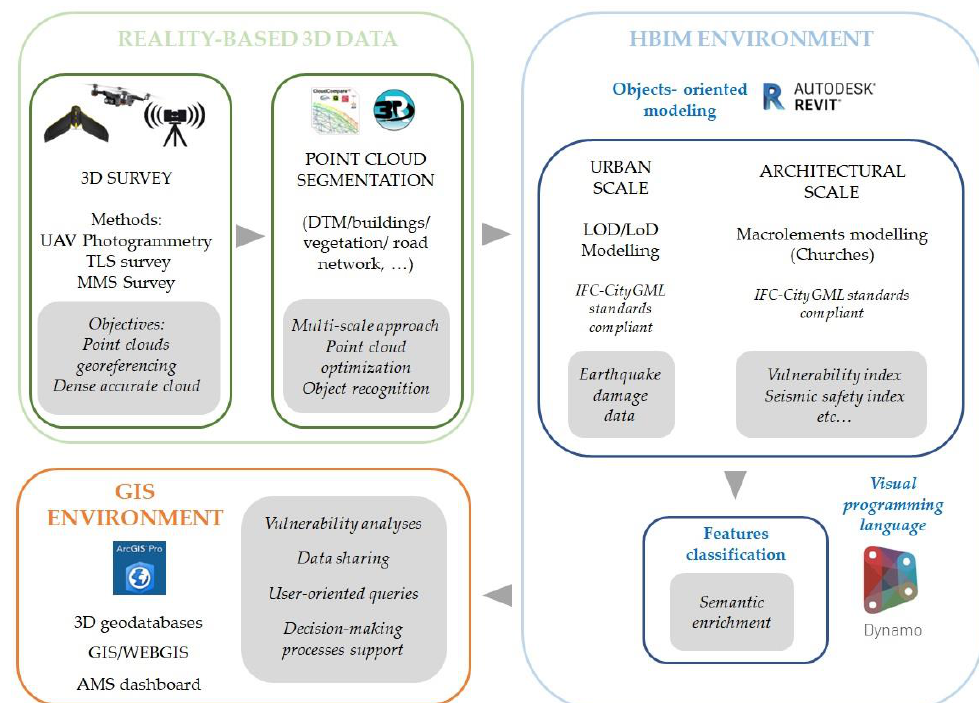
Figure 1. The main step of the HBIM modelling workflow, involving point clouds segmentation and optimization, and objects structuring according to LOD/LoD.